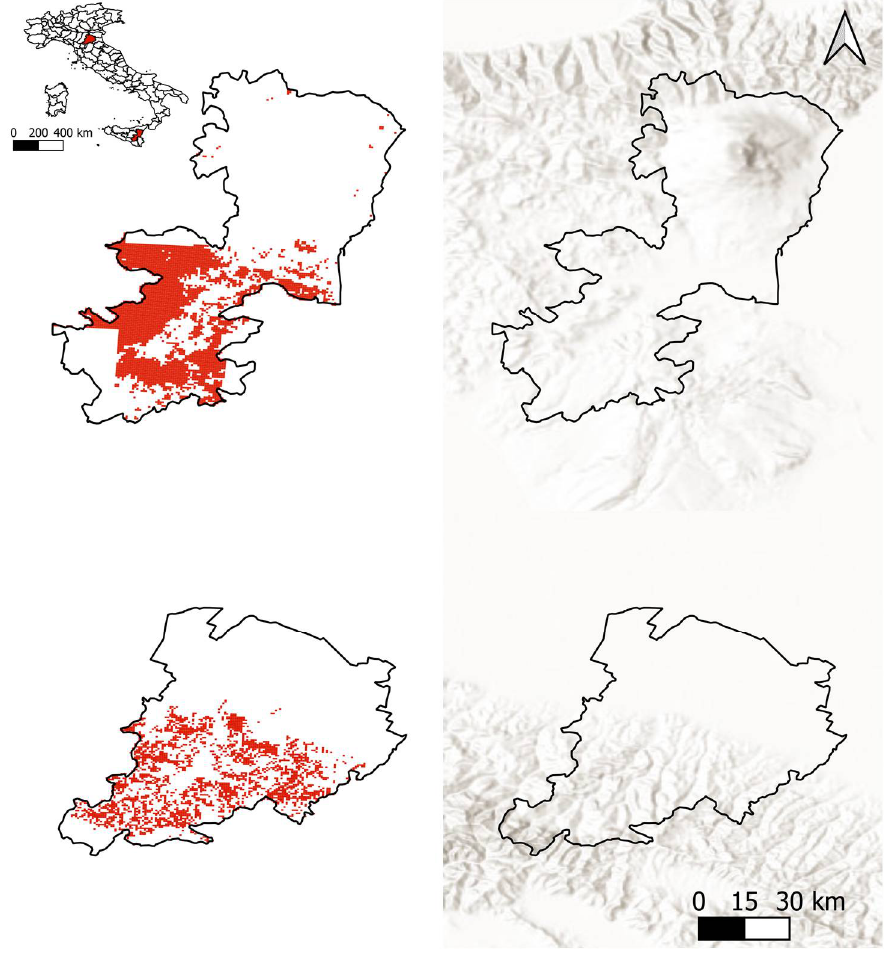
Figure 1. Marginal areas (in red) of Catania ( top panels ) and Bologna ( bottom panels ) provinces and related elevation maps ( right side ).